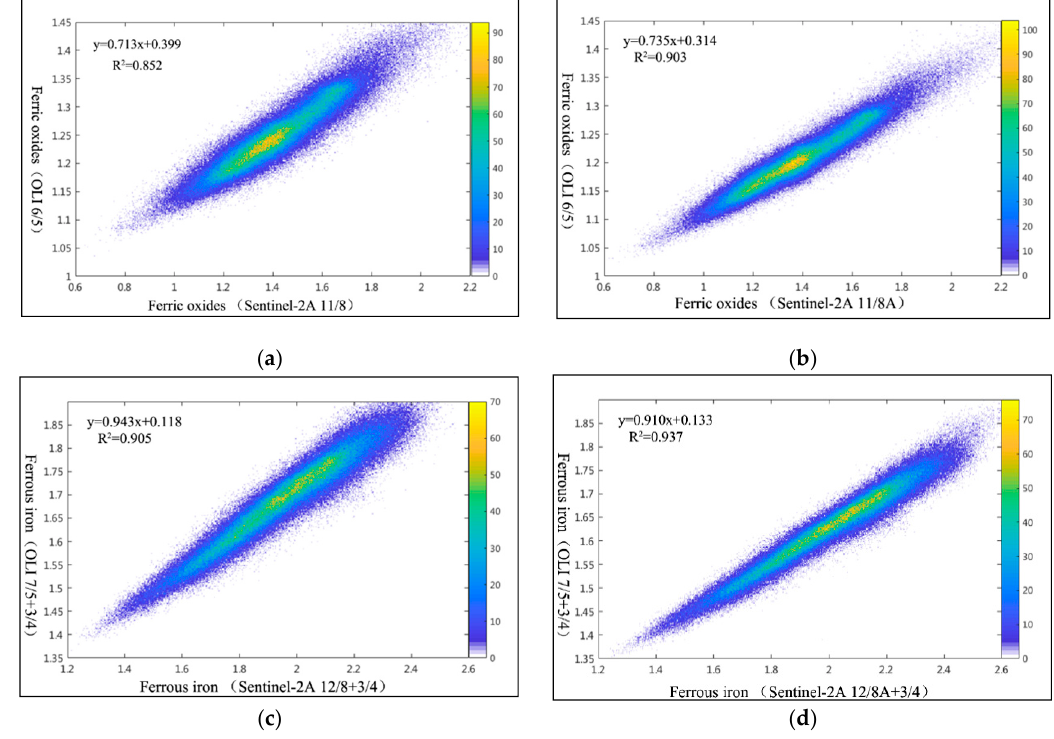
Figure 7. The scatterplots of ferric oxides and ferrous iron obtained from Landsat-8 OLI and fused Sentinel-2 images. ( a ) ferric oxides obtained from band ratios OLI 6/5 and fused Sentinel-2 11/8; ( b ) ferric oxides obtained from band ratios OLI 6/5 and fused Sentinel-2 11/8A; ( c ) ferrous iron obtained from band ratios OLI 7/5+3/4 and fused Sentinel-2 12/8+3/4; ( d ) ferrous iron obtained from band ratios OLI 7/5+3/4 and fused Sentinel-2 12/8A+3/4.